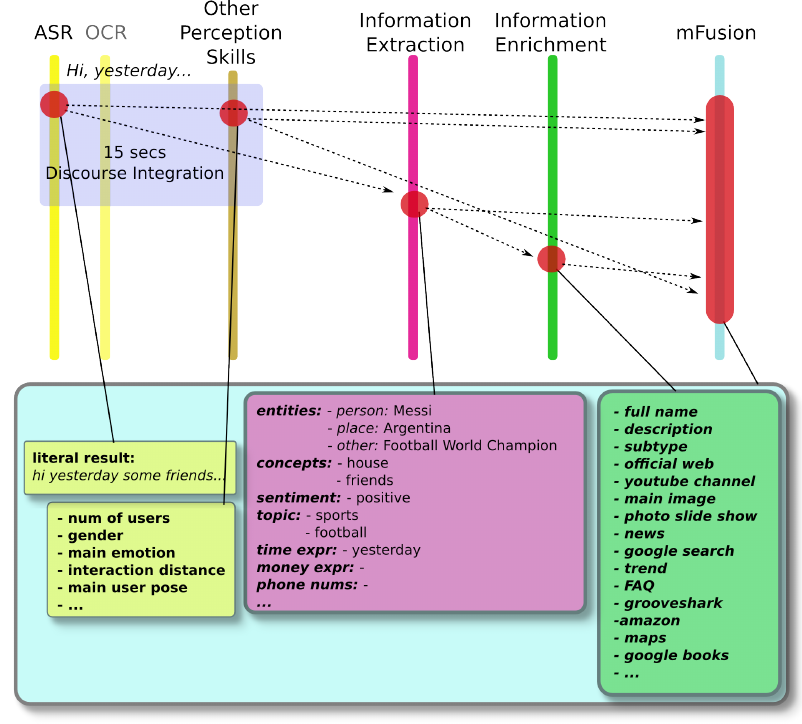
Figure 9. Information flow from user utterance to information